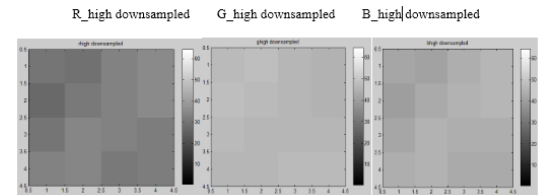
Table 1. Comparison of variances between the data for the first